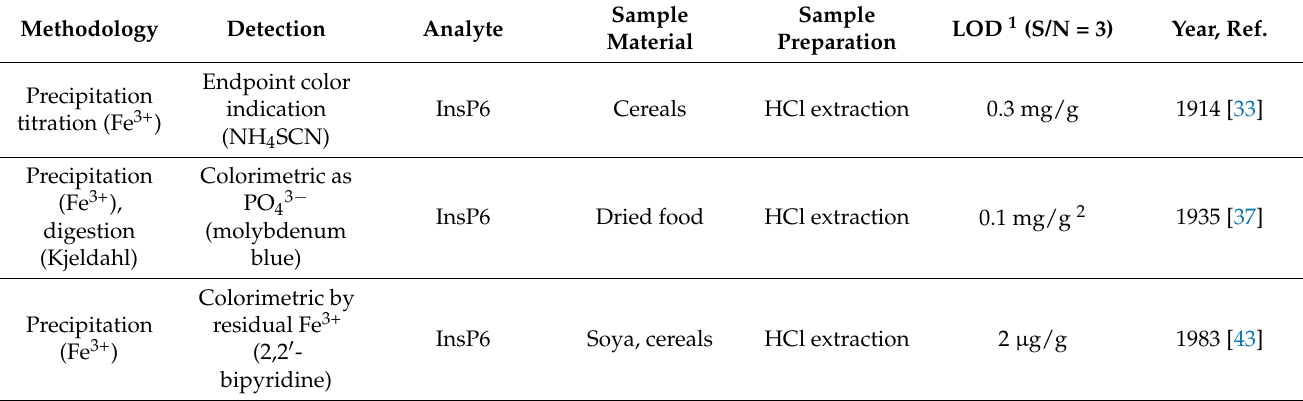
Table 1. Summary of the main analytical methods for determination of phytic acid and other inositol phosphates arranged by methodology, separation and/or detection system, analyte(s), sample material and preparation, limit of detection (LOD) 1 , year, and corresponding